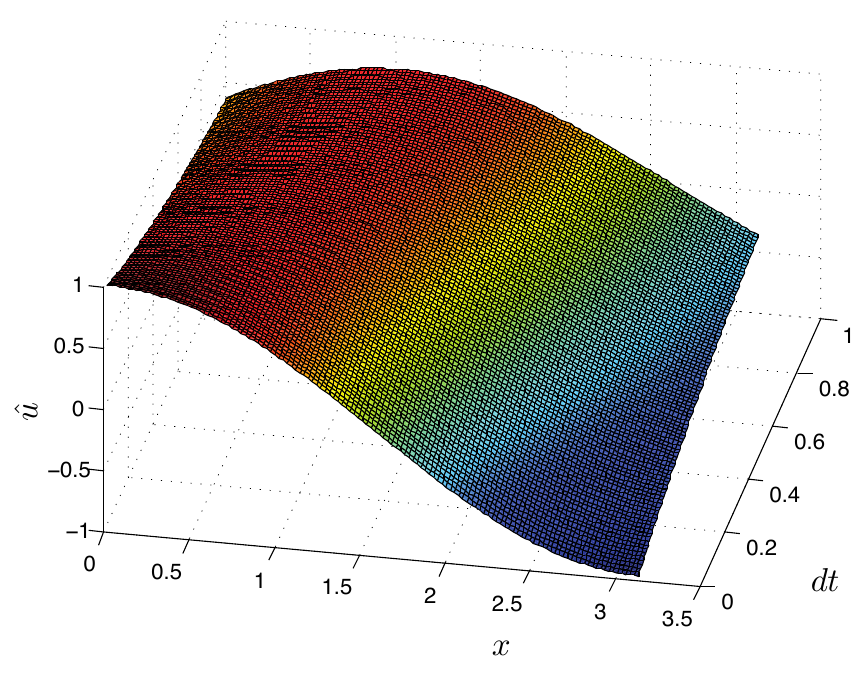
Fig. 4. Plot of the approximate solution for Test Problem 6